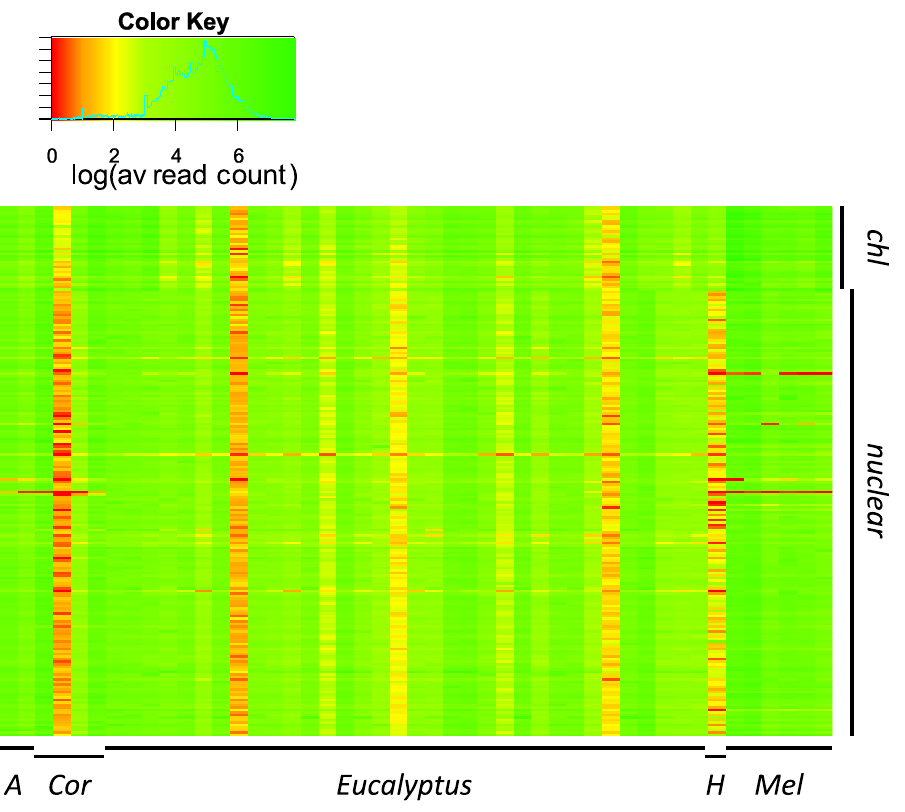
Fig 4. A heat map of the average coverage across 209 loci and 47 samples. Average reads mapped were log transformed. Samples are on the x-axis ( A = Arillastrum , Cor = Corymbia , H = Heteropyxis , Mel = Melaleuca ), loci are on the y-axis ( chl = chloroplast